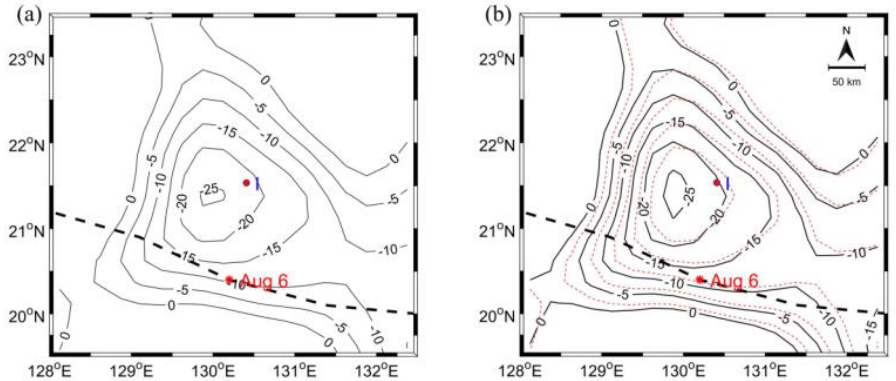
Figure 10. Negative SSHA (unit: cm) from AVISO, showing the position of the CE on 5 August ( a ) and 6 August ( b ) 2015. The symbols “I” denotes the location of Argo float on 5 August. The black dashed line is the track of typhoon and “*” denotes the center location of typhoon at 00:00 UTC on 6 August. Overlaid in ( b ) is contours of negative SSHA on 5 August (red dashed lines), implying the westward movement of the eddy.